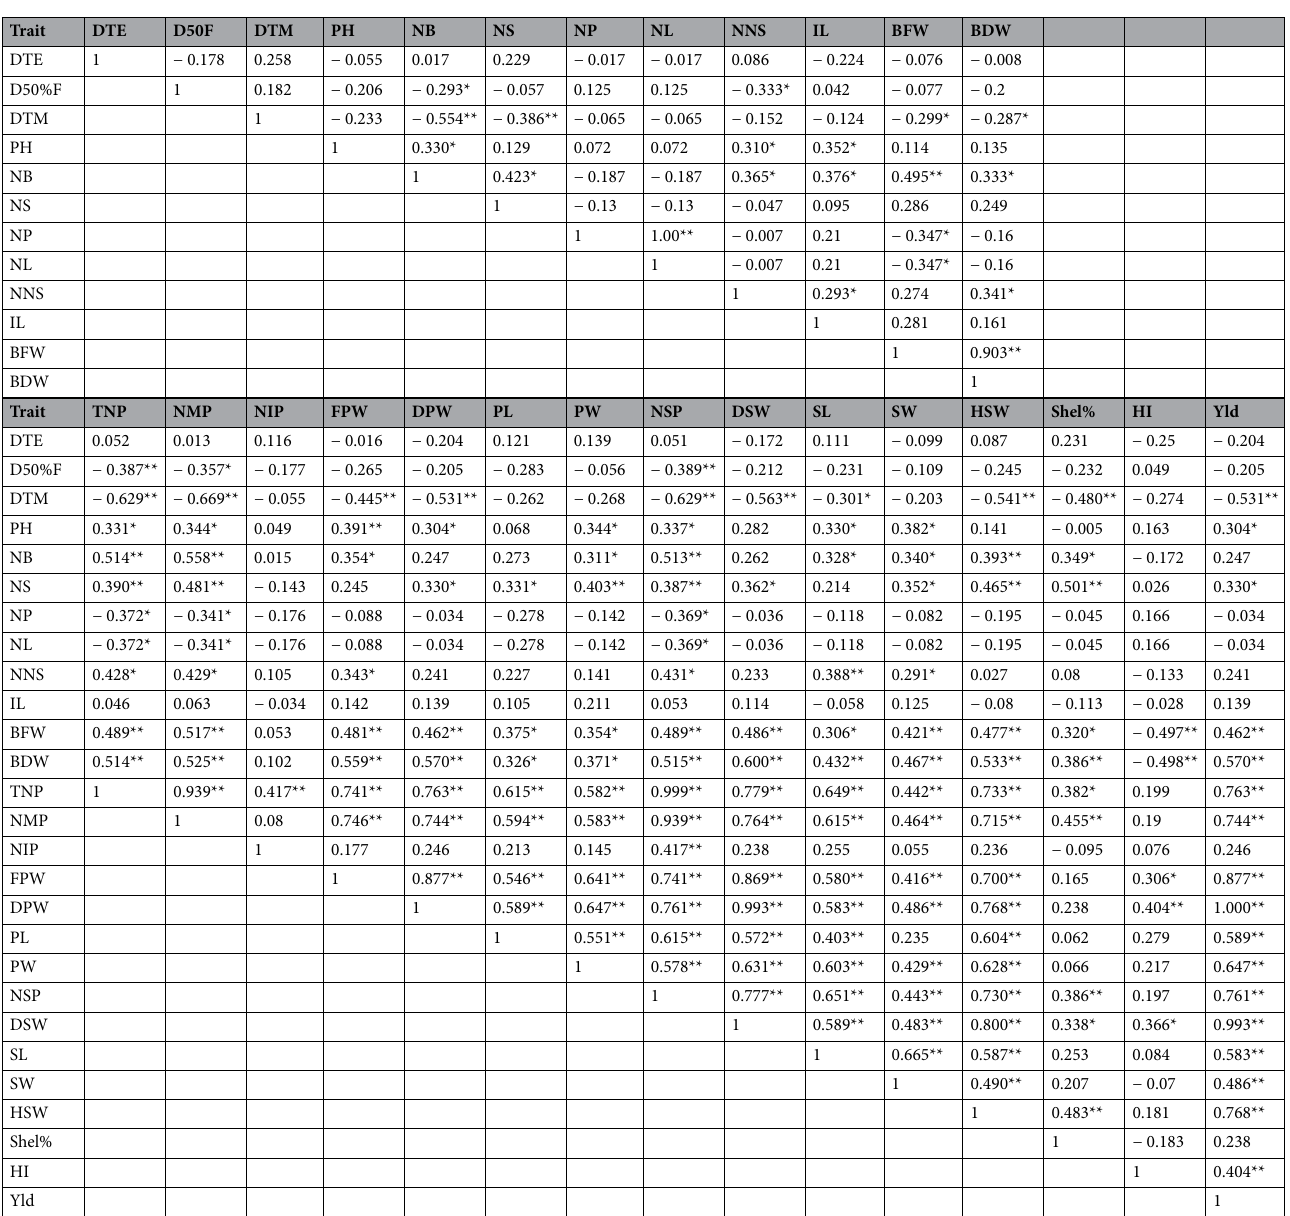
Table 6. Pearson’s Correlation matrix (r) for 27 quantitative traits of Bambara groundnut accessions. “**” correlation is significant at the 0.01 level; “*” correlation is significant at the 0.05 level, DTE (day) days